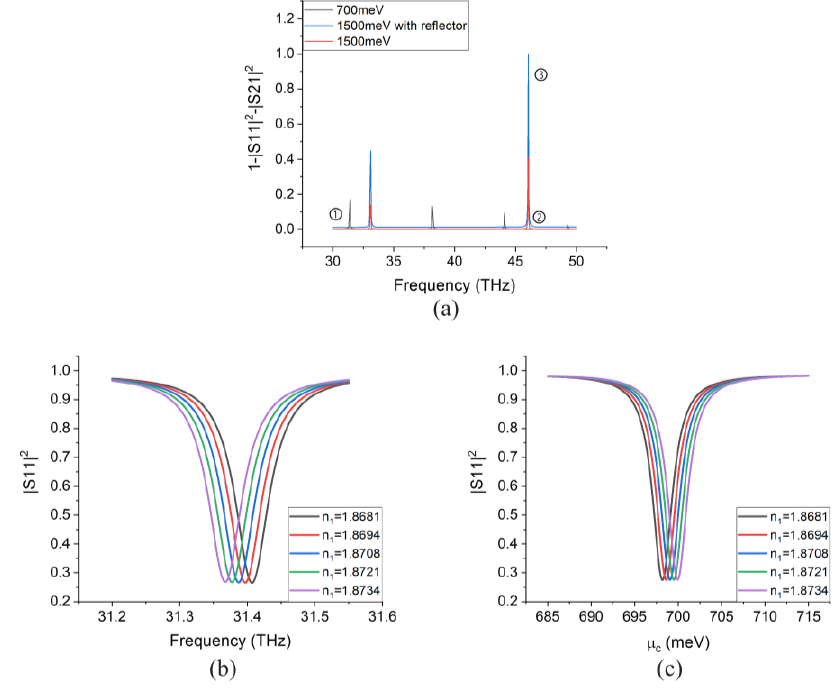
S ) for the device 11  = for different permittivities. c